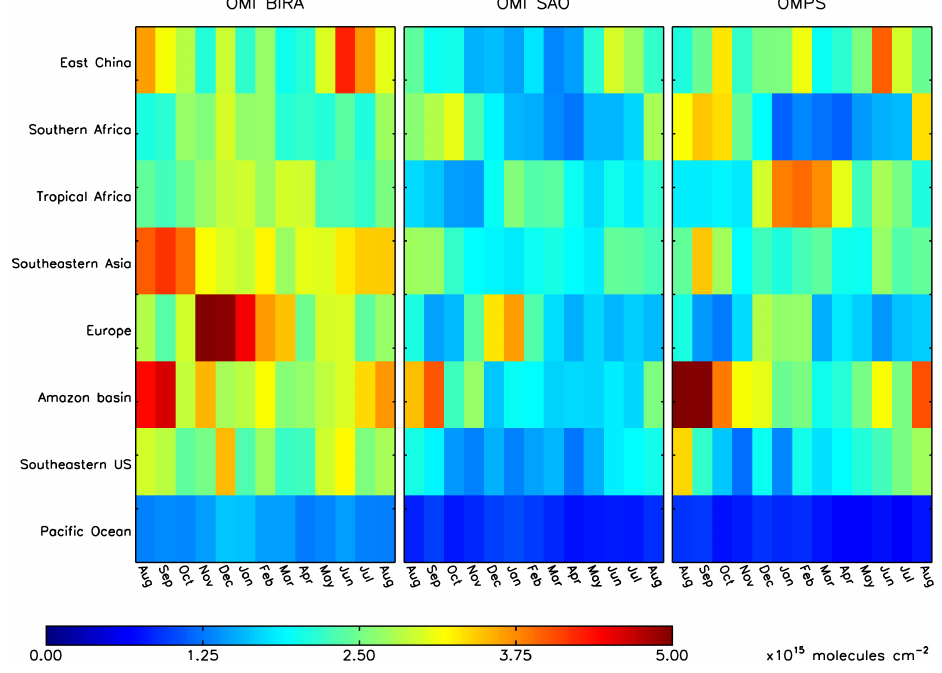
Figure 10. Standard deviation of the monthly means: (left panel) OMI BIRA, (middle panel) OMI SAO, and (right panel) OMPS SAO. Some regions show consistent enhanced standard deviations across retrievals for particular months, i.e., the Amazon basin between July and September and tropical Africa between December and March. These high variabilities are linked to biomass burning